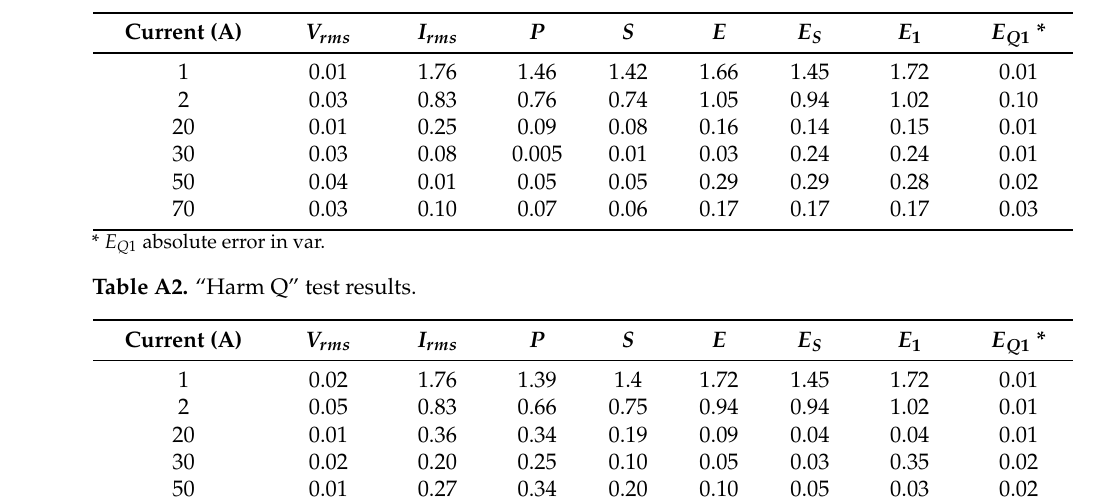
Table A1. EN 50470-3-2006 harmonics test results.